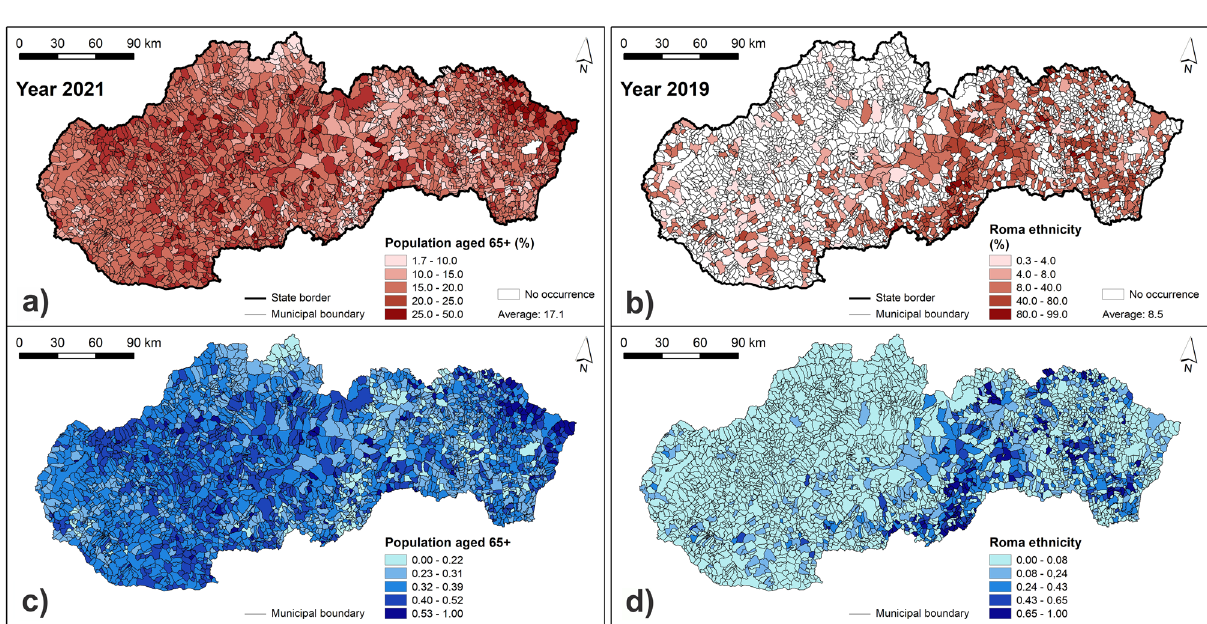
Figure 9. Indicators of the population aged 65+ and the Roma ethnicity: ( a ) original values of the population aged 65+; ( b ) original values of the Roma ethnicity; ( c ) normalized values of the population aged 65+; ( d ) normalized values of the Roma ethnicity. This figure was generated in ArcGIS 10.2.2